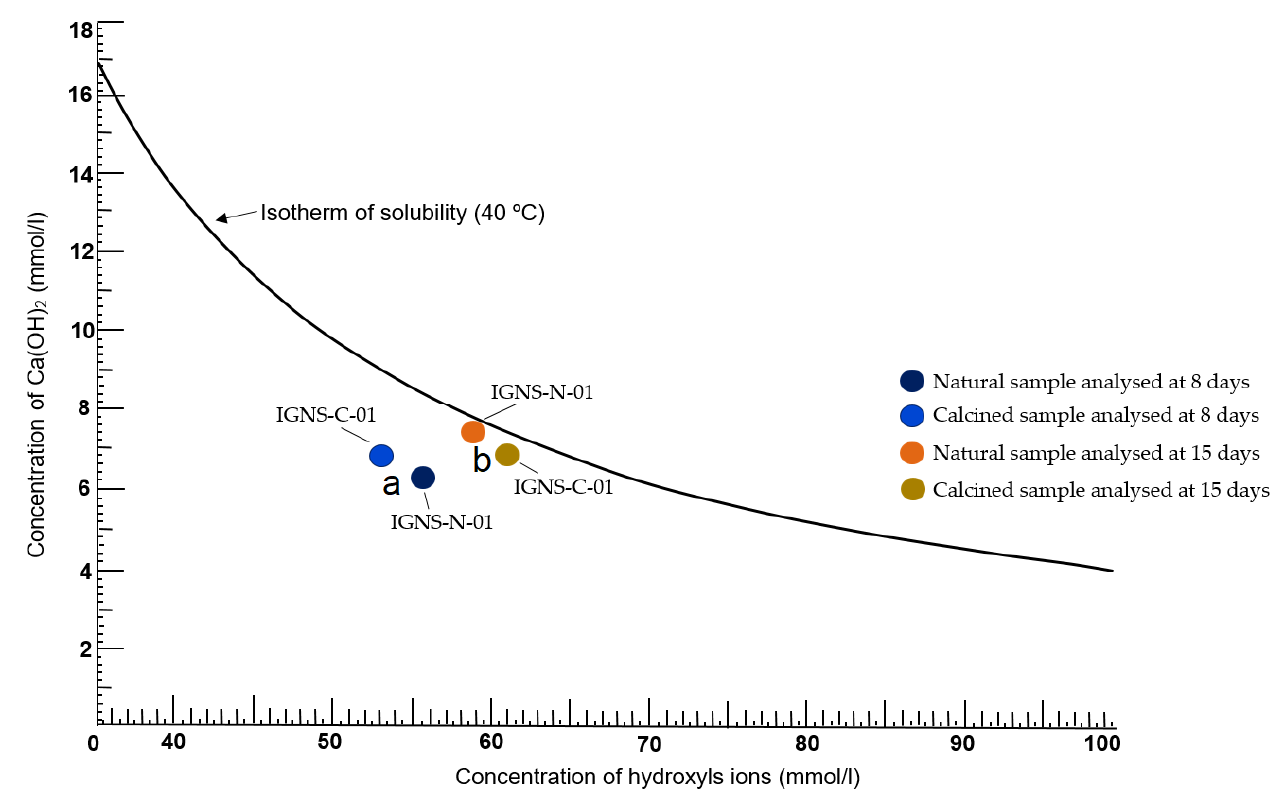
Figure 5. Pozzolanic behavior of ignimbrite samples analyzed at 8 ( a ) and 15 ( b ) days. The assay was conducted using natural (IGNS-N) and calcined (IGNS-C) ignimbrite samples.